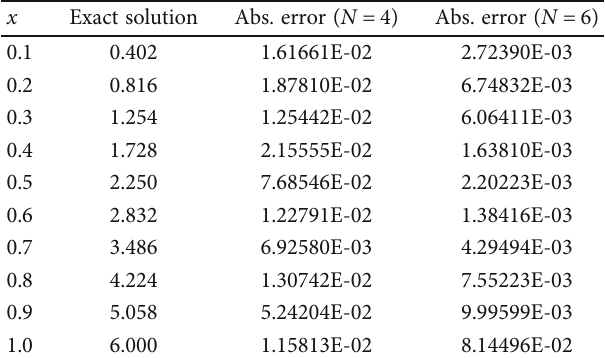
Table 1: Absolute errors obtained by proposed method with N = 4, 6 for Example